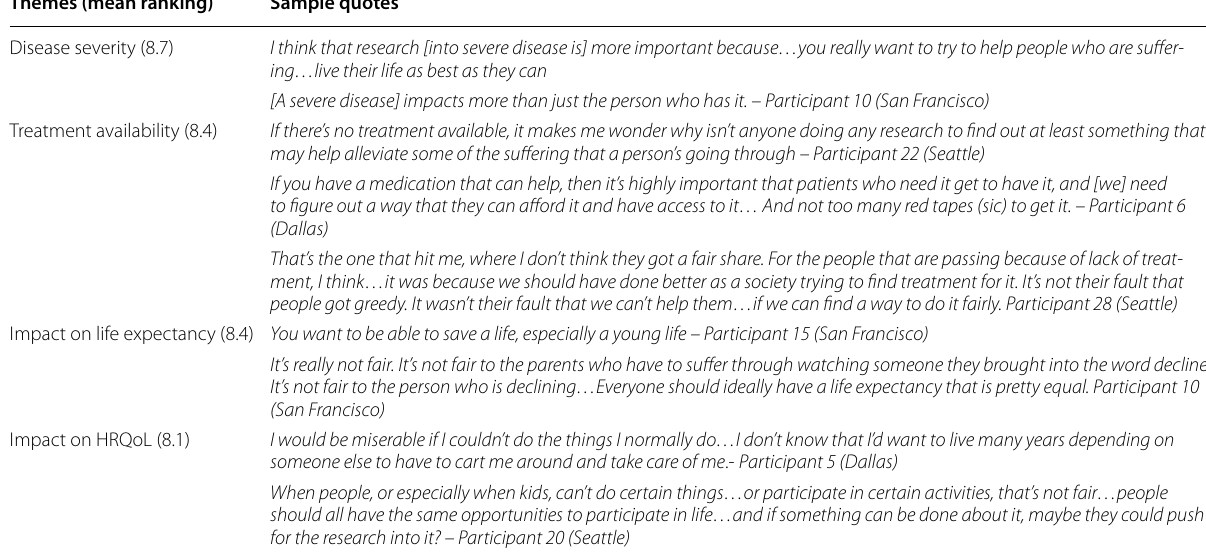
See Fig. 1 for a complete list of attributes and their rankings